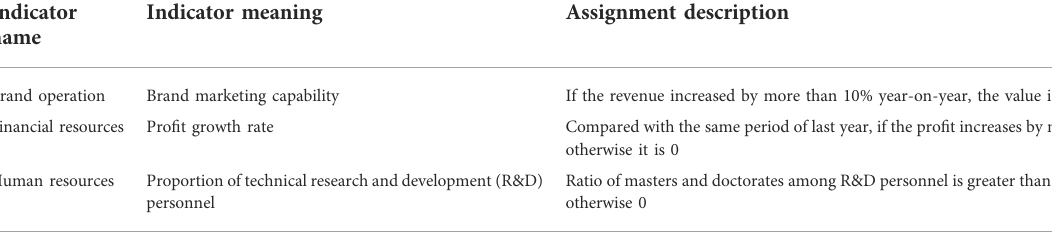
TABLE 3 Judgment standard of critical resources of manufacturing company.